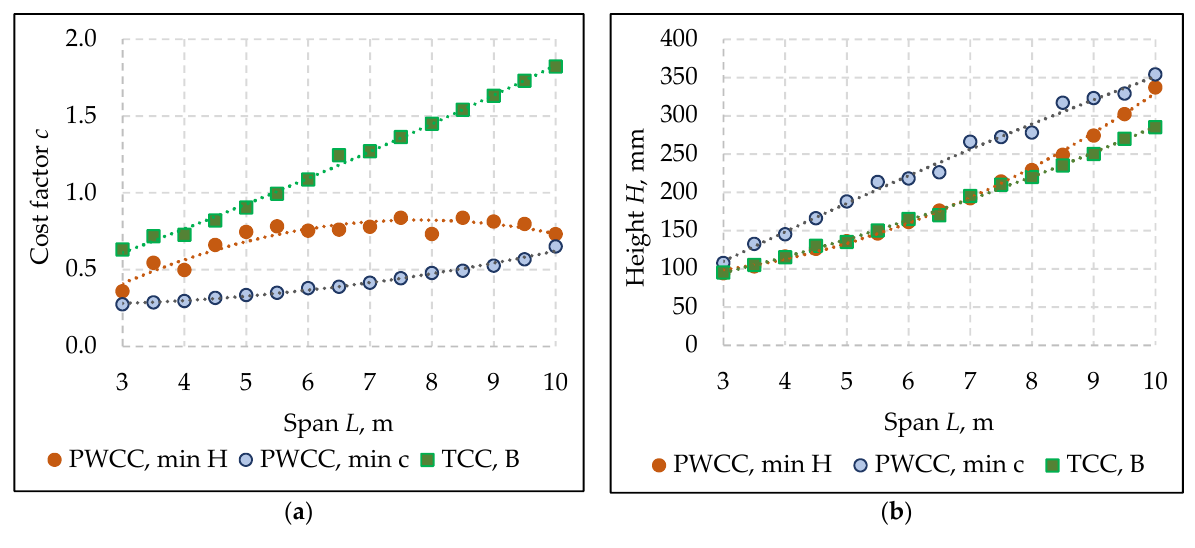
Figure 11. CLT–concrete (CLTCC) and plywood–concrete (PWCC) panels in category A1 buildings: ( a ) cost-factor dependence of the panel span; ( b ) panel-height dependence of its span, where min H —panel with the lowest height at the corresponding lowest cost factor; min c —panel with the most cost-effective cross-section, and A—multi-storey residential building.